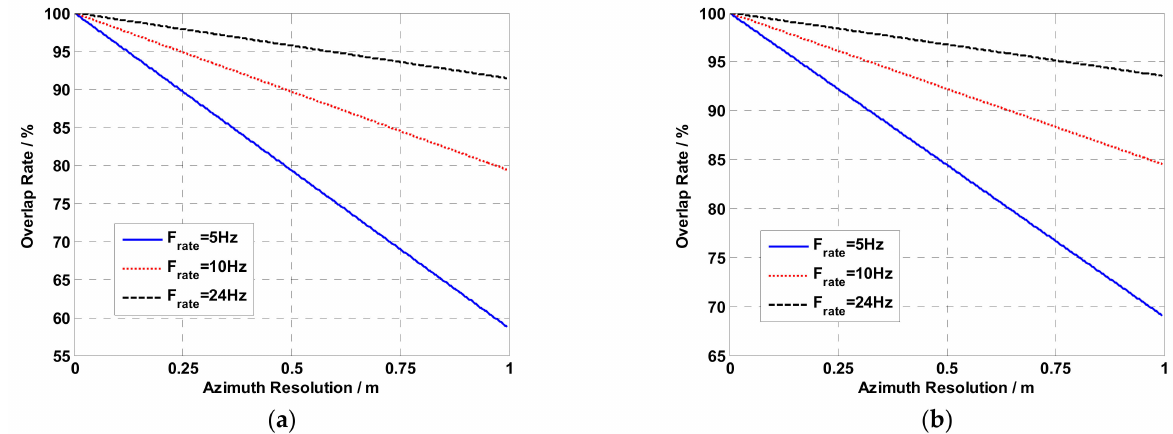
Figure 6. Overlap rate results of typical spaceborne ViSAR system with velocity of 7271 m/s and scene center slant range of 820 km. ( a ) squint angle equals to 0 degrees. ( b ) squint angle equals to 30